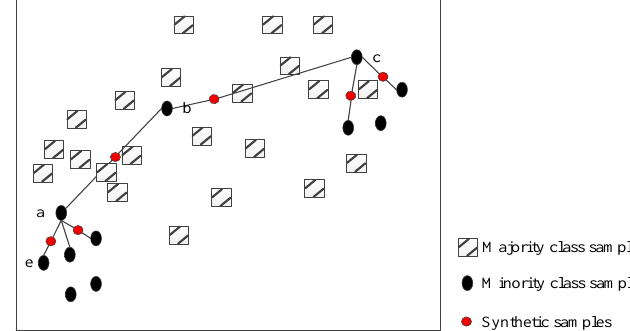
Figure 2. Diagram of the traditional SMOTE